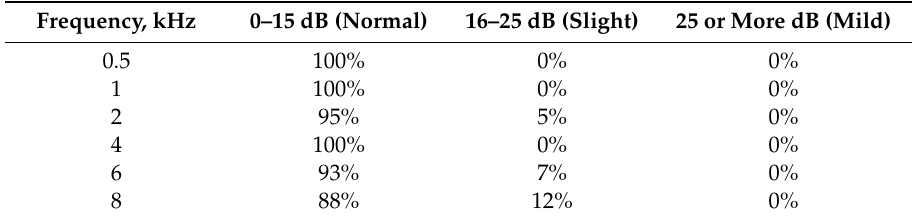
Table 6. Prevalence of hearing threshold shifts, left ear.